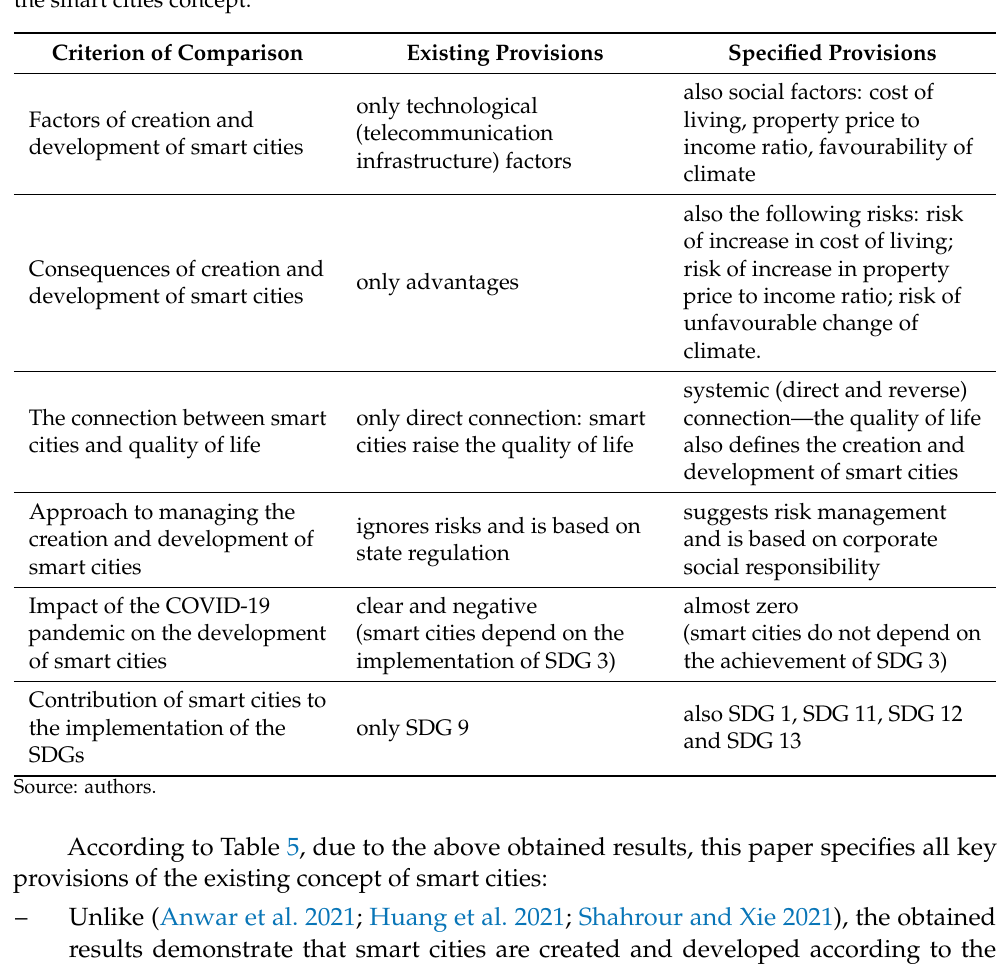
Table 5. Comparative analysis of the existing provisions and specified (in this paper) provisions of the smart cities